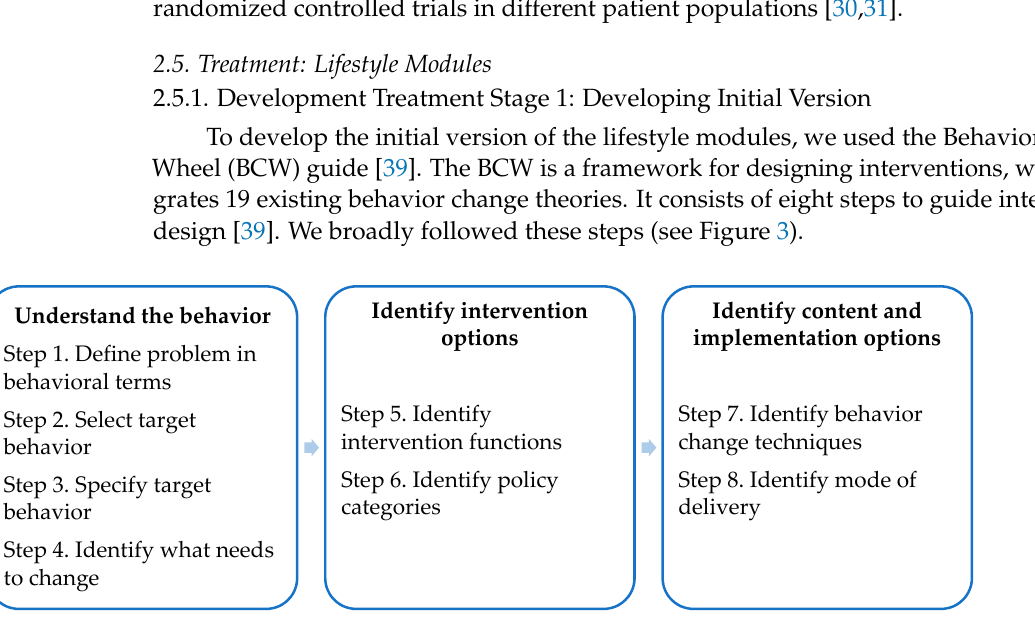
Figure 3. Eight steps of behavior change intervention design. Reproduced with permission from S. Michie, L. Atkins, and R. West, The behaviour change wheel: a guide to designing interventions; UK: Silverback Publishing, 2014.